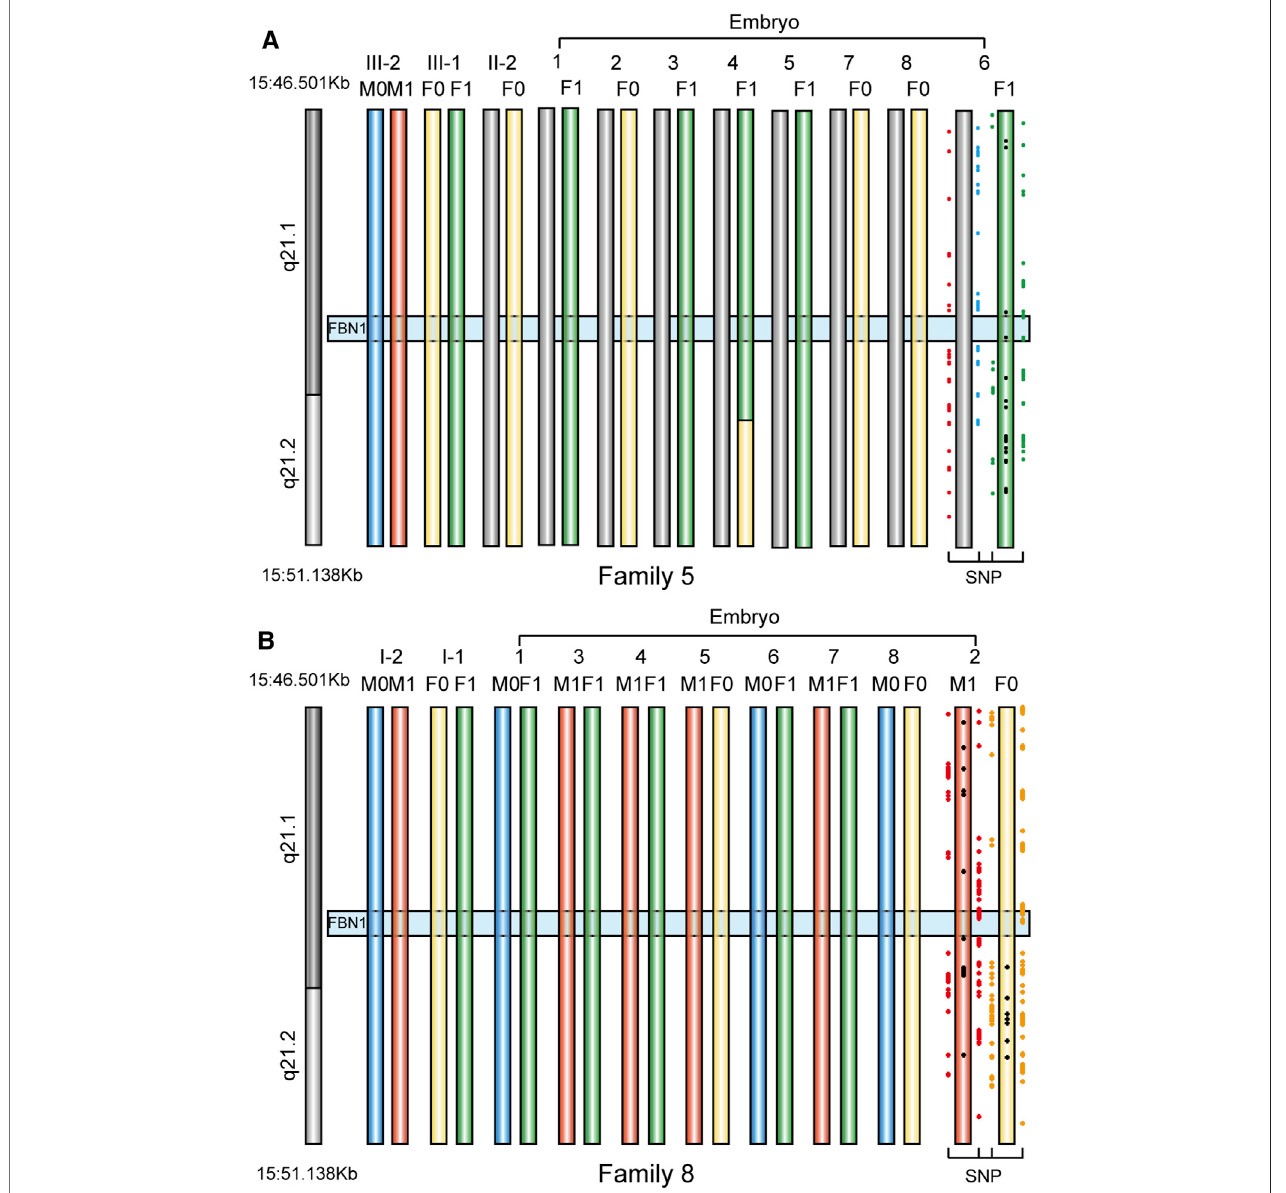
FIGURE 6 | The haplotype in FBN1 gene in eight embryos from two families. We showed informative SNPs that supported the haplotype of only one embryo used for implantation (A) PGT haplotype analysis in embryos 1 to eight in Family 5. F0 means Female disease-causing chromosome, F1 means Femalenormal chromosome, M0 and M1 means Male normal chromosome. Embryo 4 had a recombination event in the maternal allele (length 869.56 Kb), but it did not in fl uence the genotype deductionofthe FBN1 gene,becausetherecombinationlociwereoutsidethegeneregion (B) PGThaplotype analysisinembryos1toeightinFamily8.M0means Male disease-causing chromosome, M1 means Male normal chromosome, F0 and F1 mean Female normal